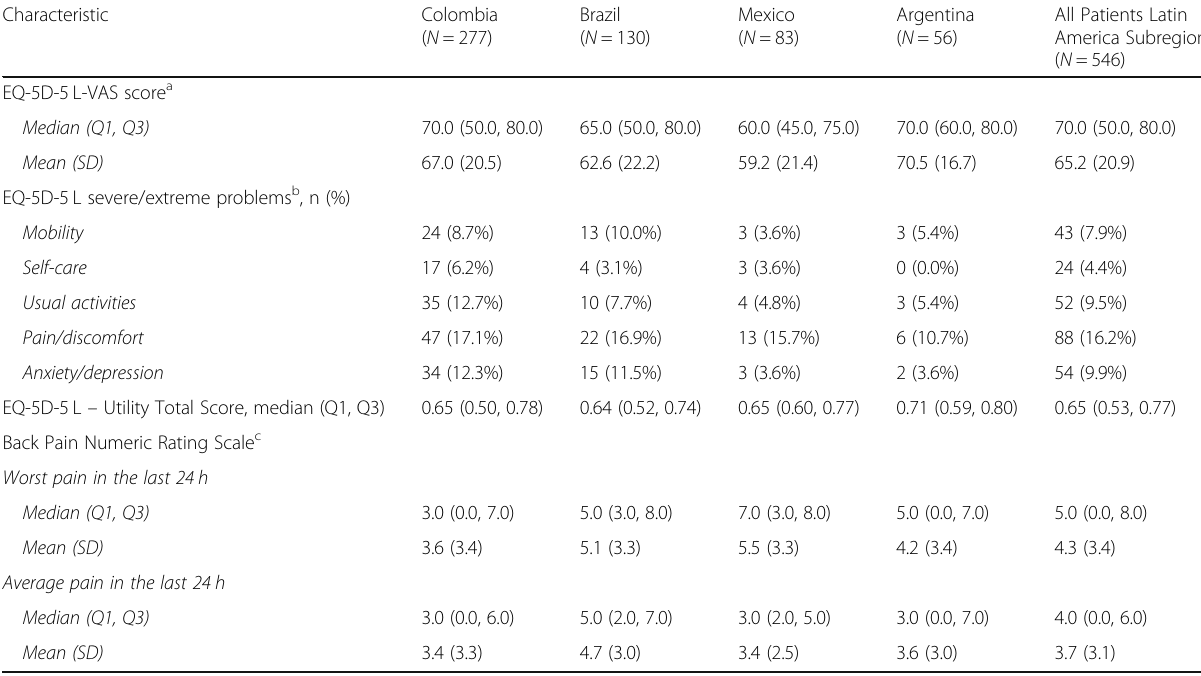
Table 4 Health-related quality of life scores at baseline